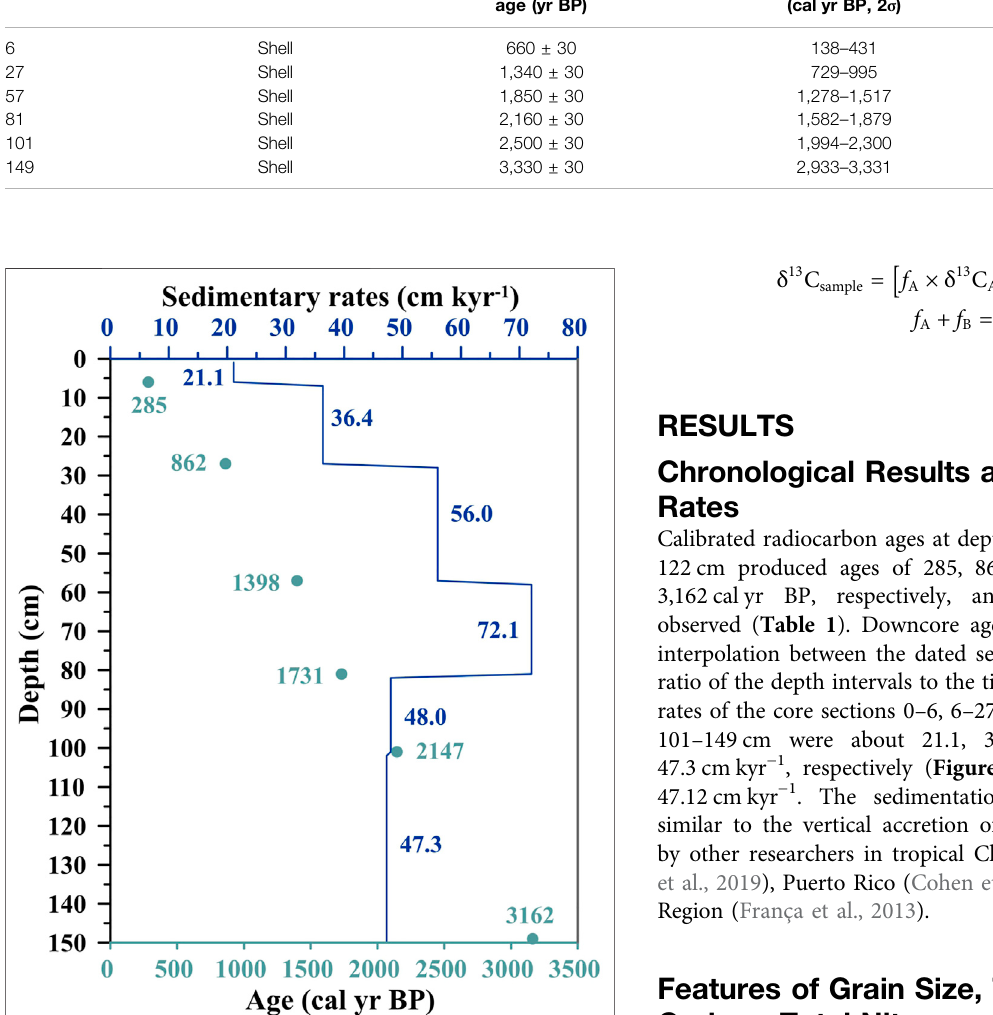
TABLE 1 | List of AMS 14 C ages from core Q43. Depth (cm)